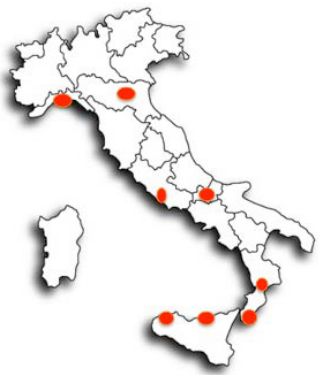
Figure 1. Italian centers participating to the study.